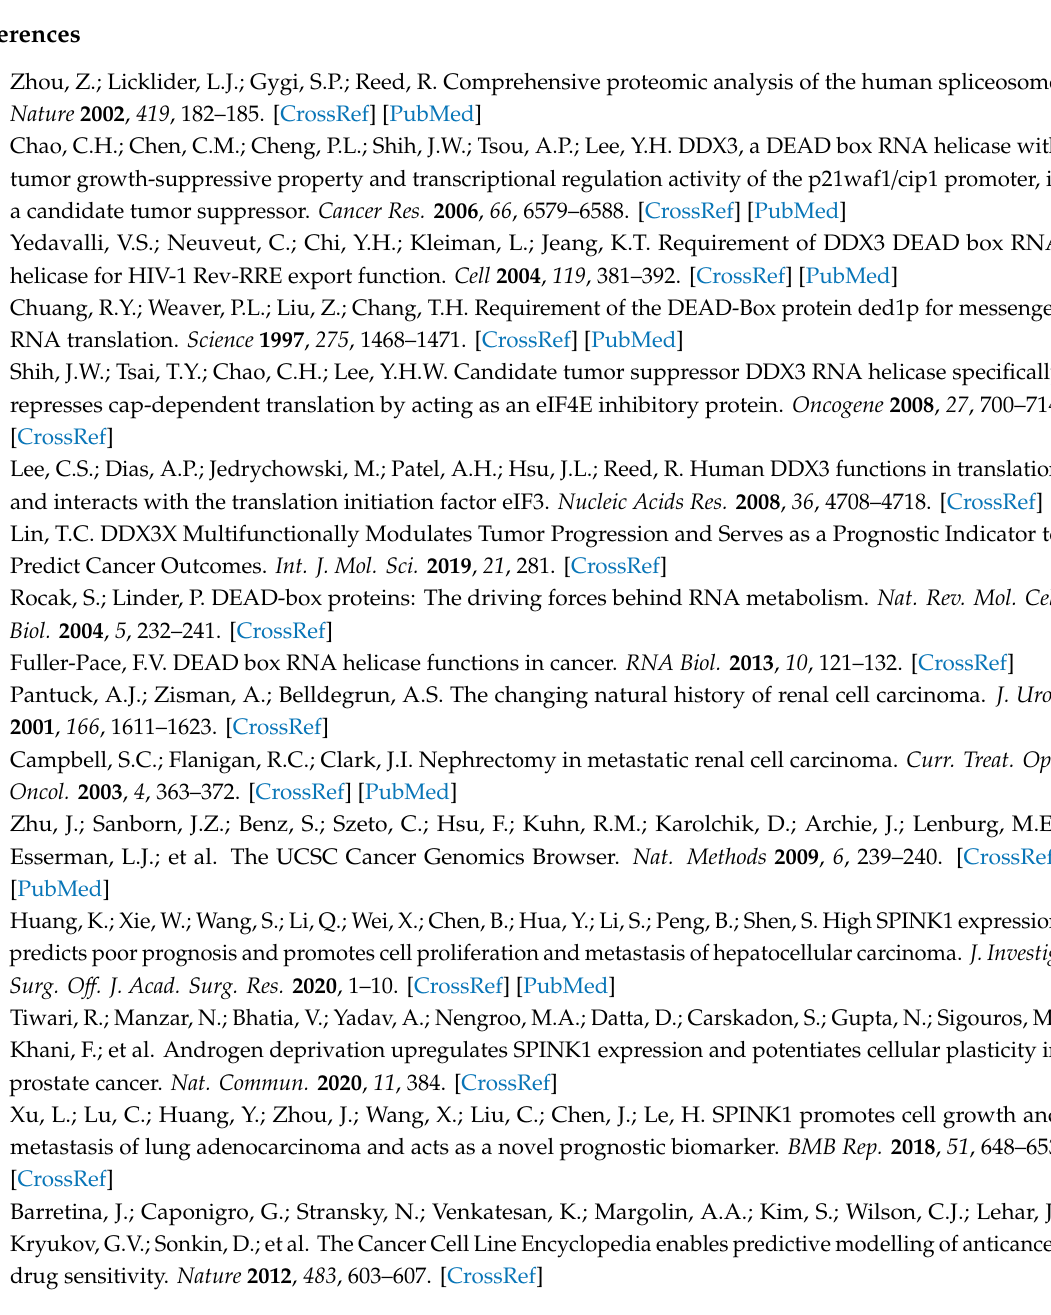
s1. Figure S1. DDX3X is epigenetically repressed in tumor tissue of RCC subtype: papillary cell carcinoma. Figure S2. Treatment of DNA methyltransferase (DNMT) inhibitor 5-Aza-2’-deoxycytidine (5-azadC) results